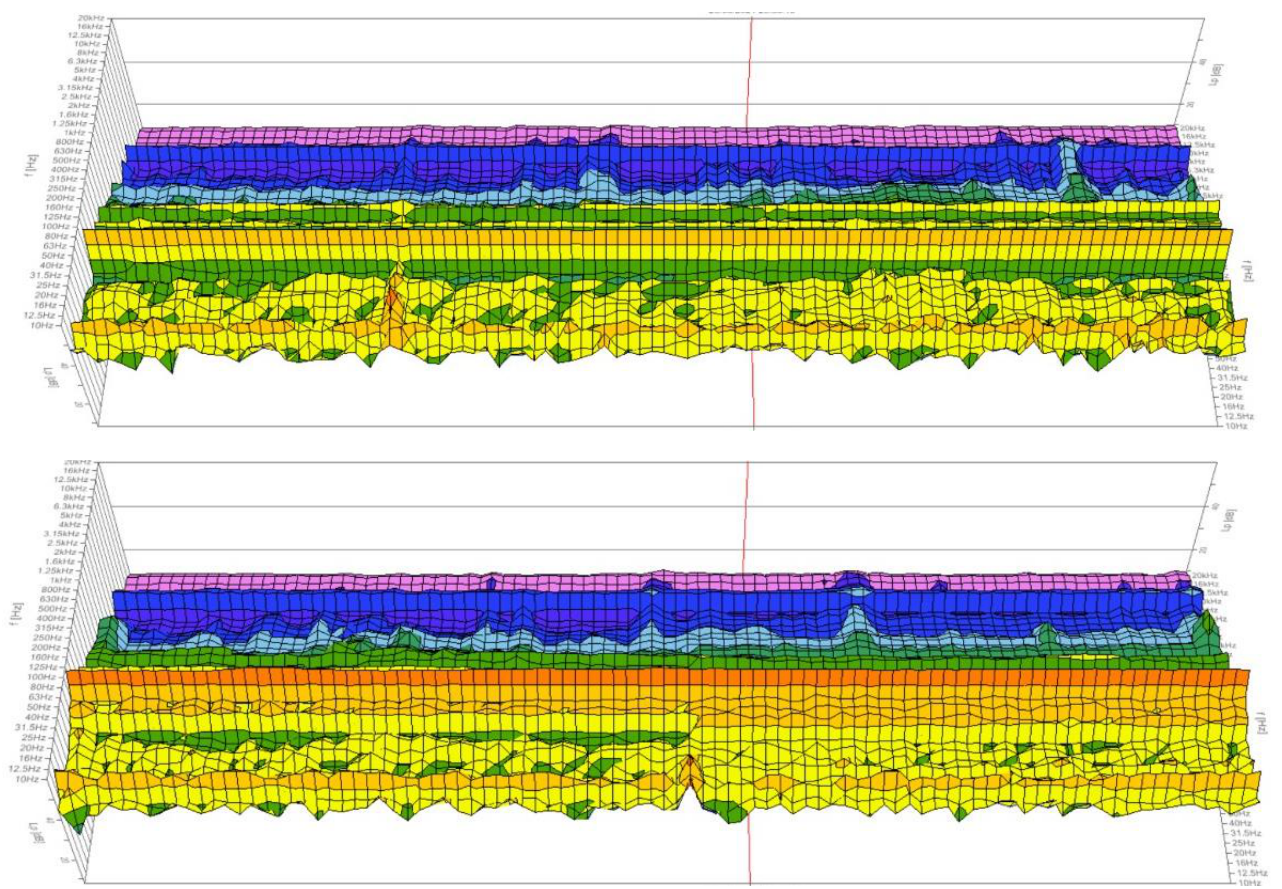
Figure 9. Spectrograms of the sound pressure levels measured at measurement point #6, in the absence and presence of sound masking. The top image refers to spectra measured with the masking system turned off, while the bottom image refers to spectra measured under the effect of the masking system.